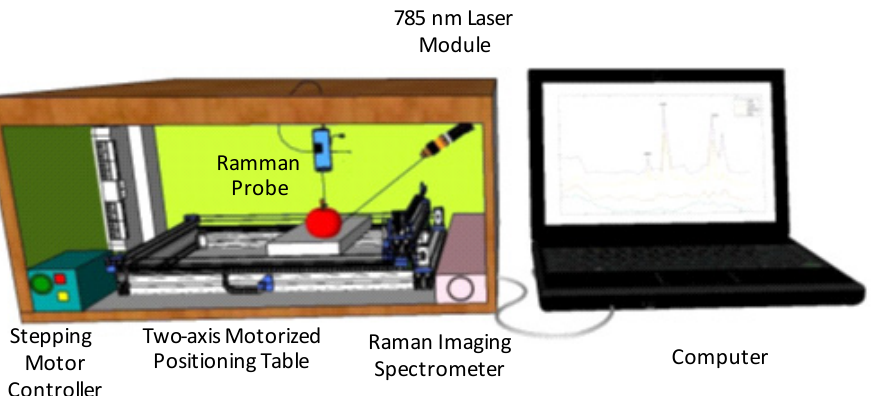
Figure 9. Spectra of tomato maturity behavior using Raman spectroscopy [84].